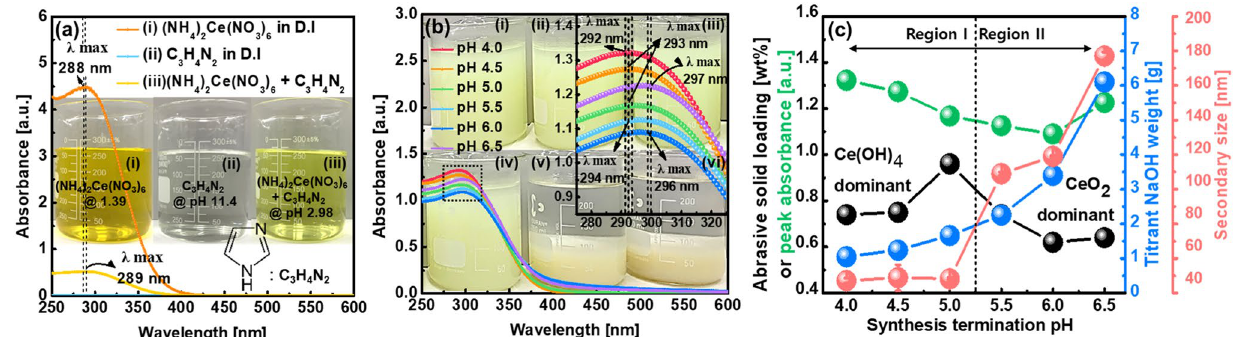
Figure 2. Dependencies of chemical and material properties of super-fine wet ceria abrasives on synthesis termination pH. ( a ) Chemical solution color of (i) precursor (NH 4 ) 2 Ce(NO 3 ) 6 dissolved in DI water, (ii) C 3 H 4 N 2 dissolved in DI water, and (iii) (NH 4 ) 2 Ce(NO 3 ) 6 and C 3 H 4 N 2 dissolved in DI water. ( b ) Peak absorption wavelength and absorbance dependent on synthesis termination pH. Beaker (i), (ii), (iii), (iv), (v), and (vi) of